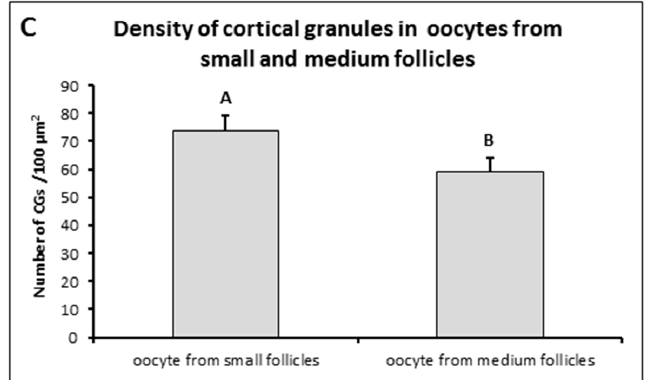
Figure 2. Cortical granule density after IVM. Representative images of porcine oocytes periphery after 44 h maturation in oocytes from small ( A ) and medium ( B ) follicles. Oocytes were stained by PNA- labeled FITC (green color—cortical granules). Scale bar represents 10 µm. The mean (±SD) of cortical